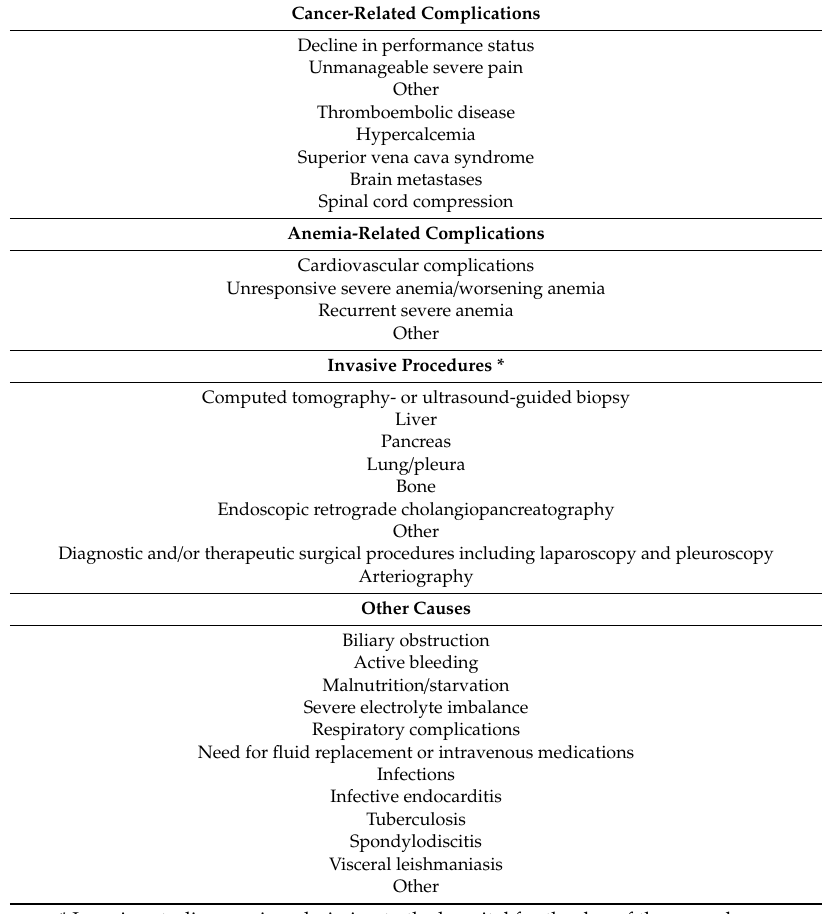
Figure 2. Temporal trends in admission rates for patients evaluated at the quick diagnosis unit from 2004–2005 to 2018–2019. Table 2. Categories of reasons for